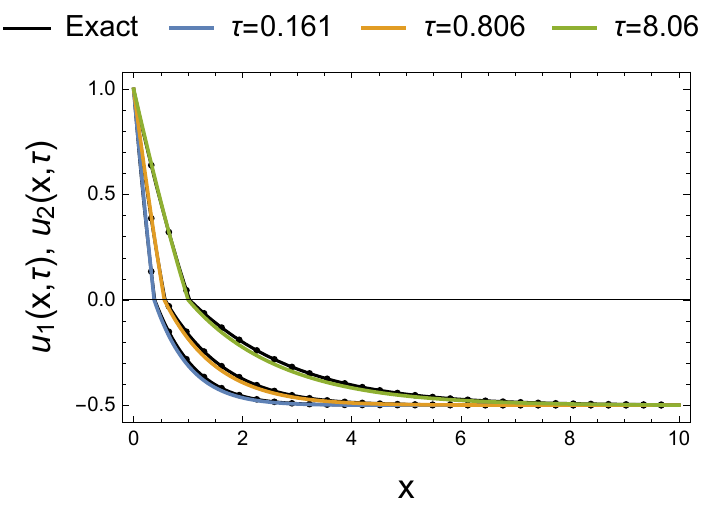
Figure 5. Numerical solution of u 1 , u 2 for α = 0.5, λ 1 = 1, λ 2 = 2, κ 1 = 1, κ 2 =